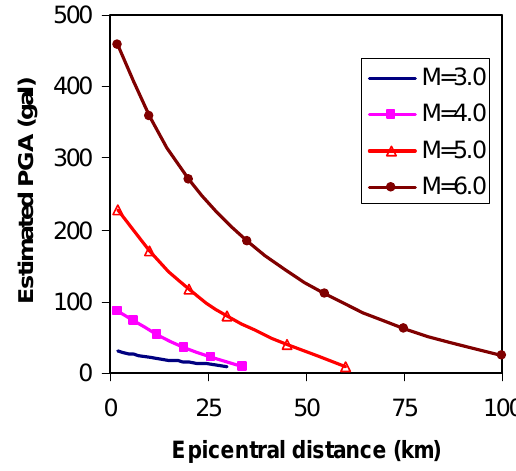
Fig. 8. Attenuation of the PGA with respect to epicentral Figure 8. Attenuation of the PGA with respect to epicentral distance